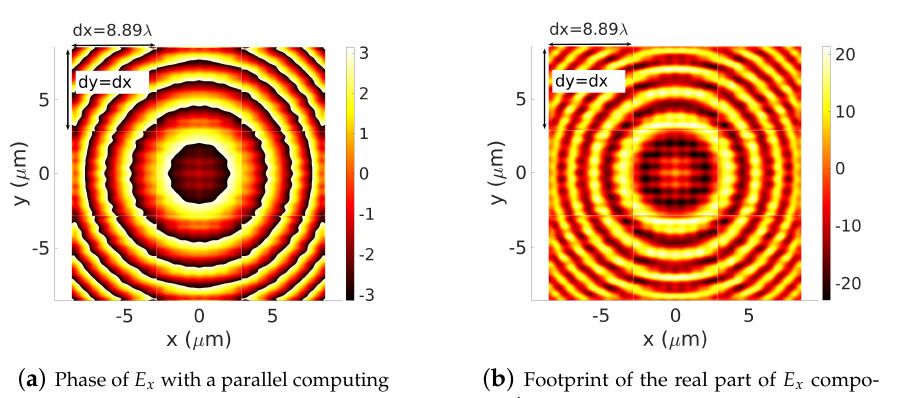
Figure 6. Footprints of the phase ( a ) and the real part ( b ) of an E x electric dipole in the plane z = − 20 λ . The whole domain [ − 0.5 D x ,0.5 D x ] × [ − 0.5 D y ,0.5 D y ] is divided into a 3 × 3 sub-cell Ω ij . Based on the proposed parallel strategy, the numerical computation is performed on each sub-cell Ω ij . The